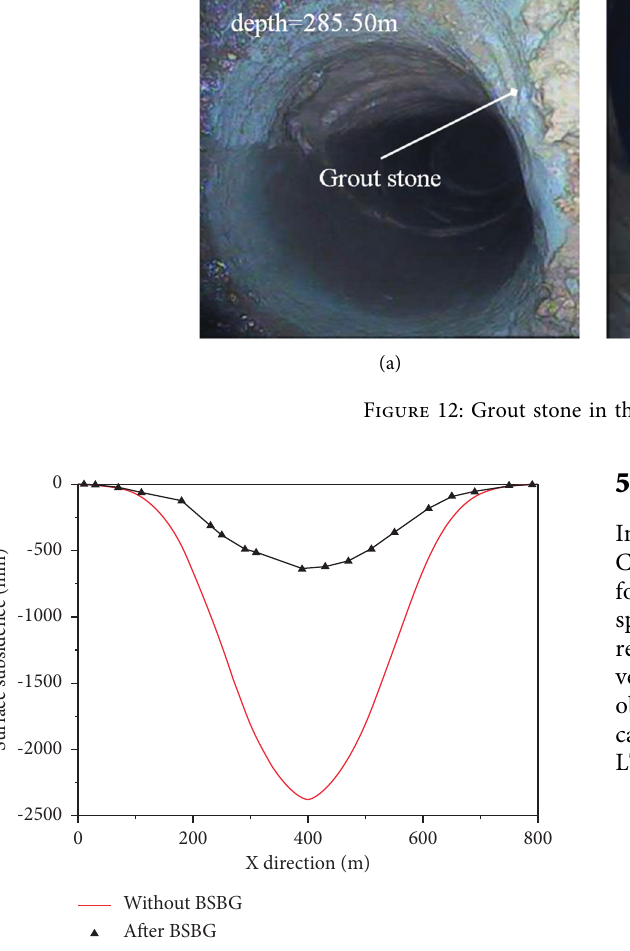
Figure 13: Surface subsidence measurements after the BSBG